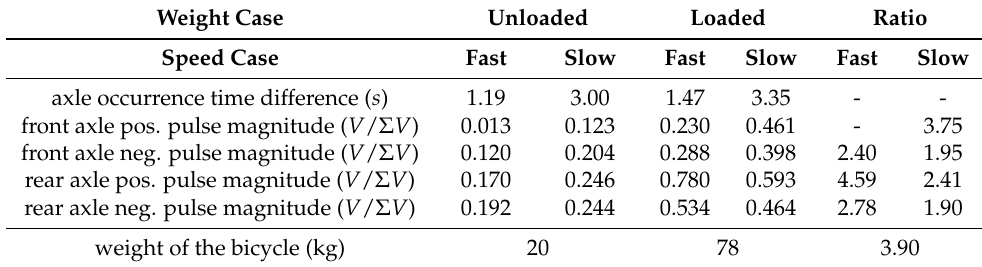
Table 3. Characteristics of loads and signal response from the bicycle passing tests. The values obtained from unloaded and loaded cases are listed together with the loaded/unloaded